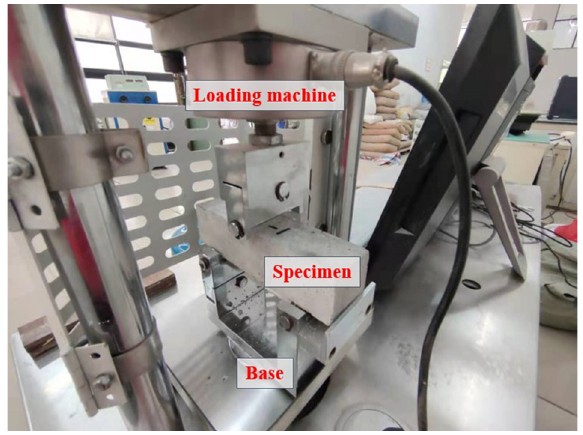
Figure 6: Prism fl exural and compression test machine.